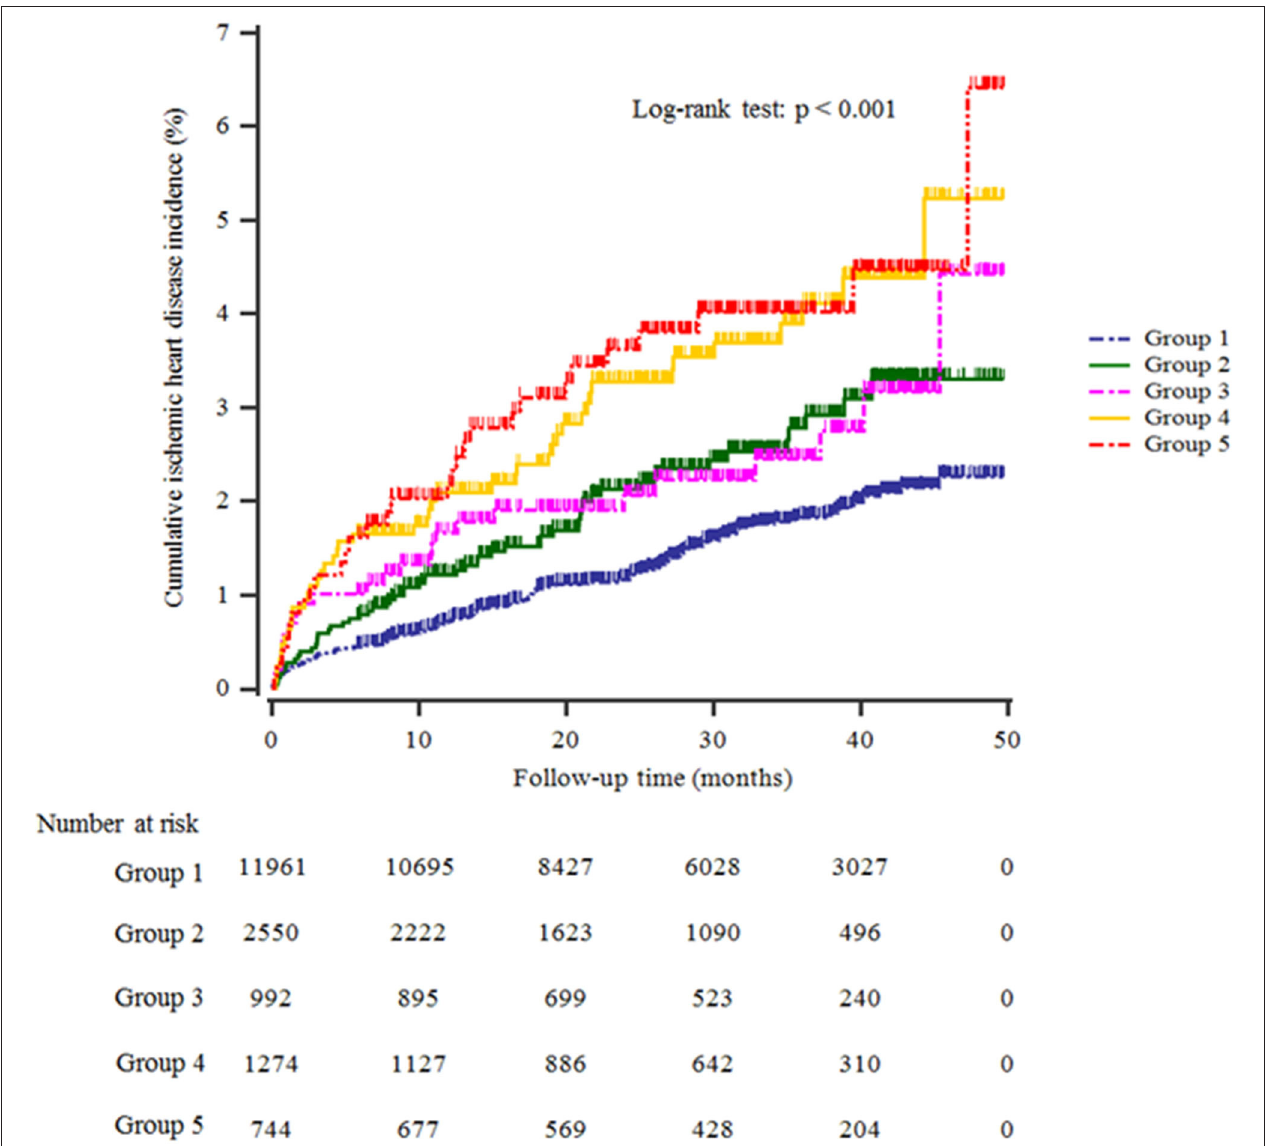
FIGURE 2 | Kaplan–Meier plots indicating the cumulative probability of being diagnosed with ischemic heart disease after the baseline